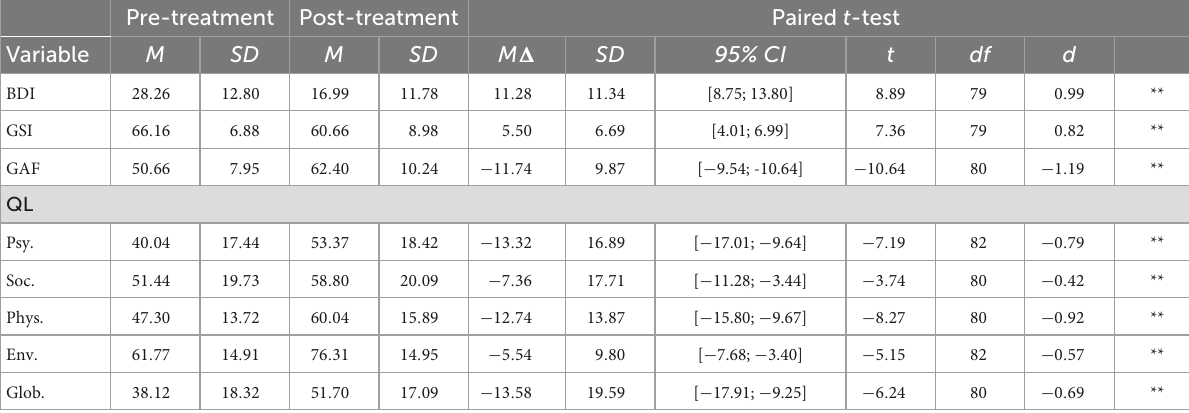
TABLE 2 Contrast of pre-treatment with post-treatment in study